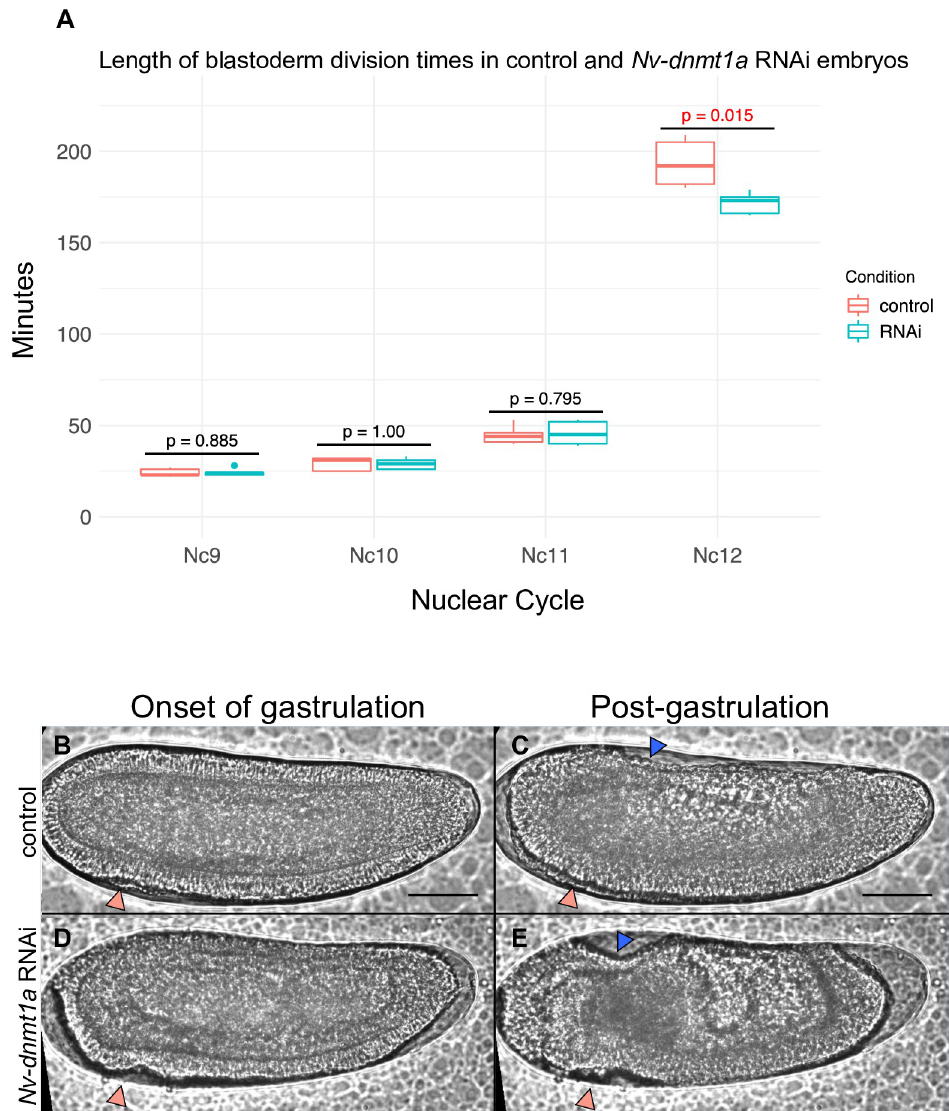
Fig 1. Live imaging of control and Nv-dnmt1a RNAi embryos. A) Box and whisker plot displaying the length of blastoderm division times that were measured during live imaging experiments. Nc = nuclear cycle #. P values were determined by performing a 2-tailed T-test assuming unequal variance between RNAi and control. N = 5 control, N = 5 Nv-dnmt1a RNAi. B-C) Live-imaging of a control embryo at the onset of gastrulation and at post-gastrulation. Peach arrows in (B) point to the initial mesodermal folds which are eventually internalized C. The blue arrowhead in C points to the serosa. Scale bars (black lines in B and C) are 50 μ m. (D-E) Live-imaging of a Nv-dnmt1a RNAi embryo at the onset of gastrulation and at what is equivalent to post-gastrulation. Defective mesodermal folds are denoted by peach arrowheads in D and E. Abnormal serosal movements are denoted by a blue arrowhead in E.